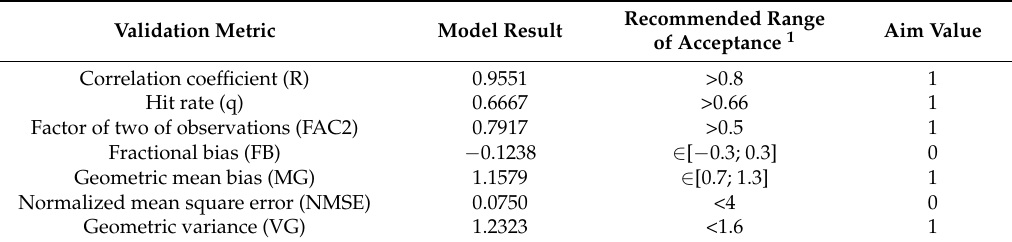
Table 3. Validation metrics of the normalized concentration results.